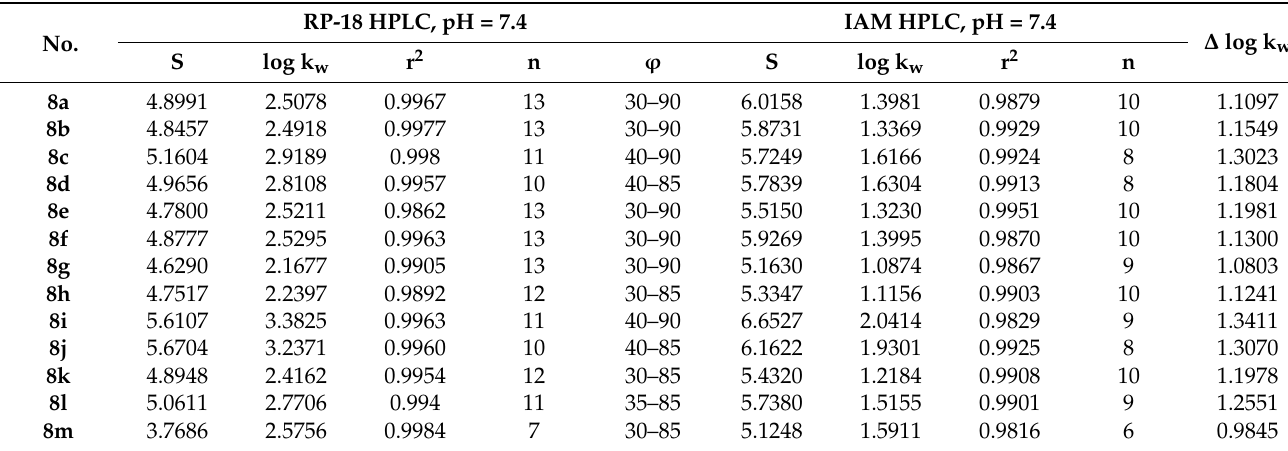
Table 5. The lipophilicity parameters of compounds (log k w(RP − 18) and – S values (Equation (1)) obtained by RP-18 and immobilized artificial membrane (IAM) HPLC chromatography (pH =